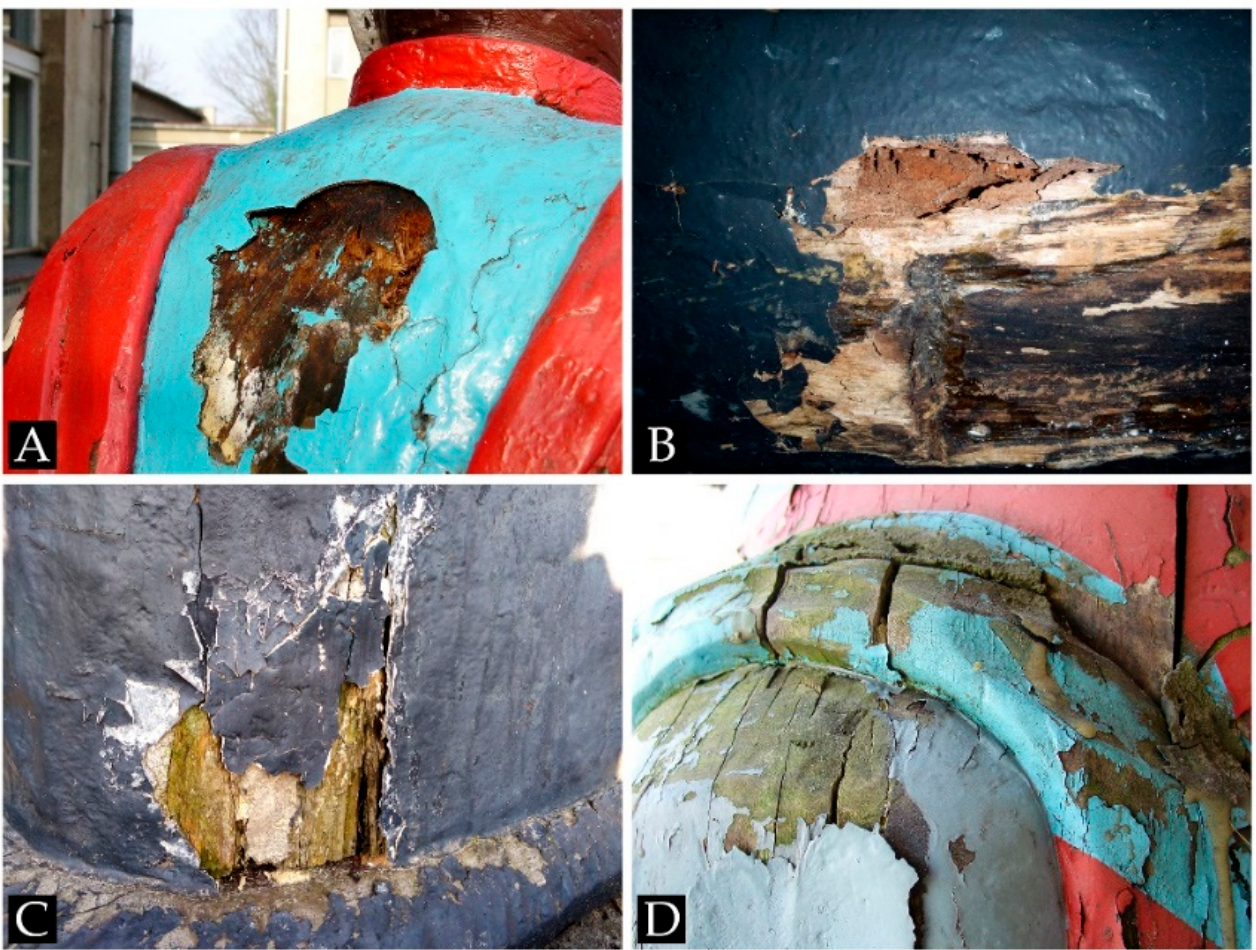
Figure 4. Damage of wooden objects covered with paints (( A – D ): artefacts from the collection of The Museum of Apiculture in Swarz ę dz, a branch of The National Museum of Agriculture and Food Industry in Szreniawa, Poland).